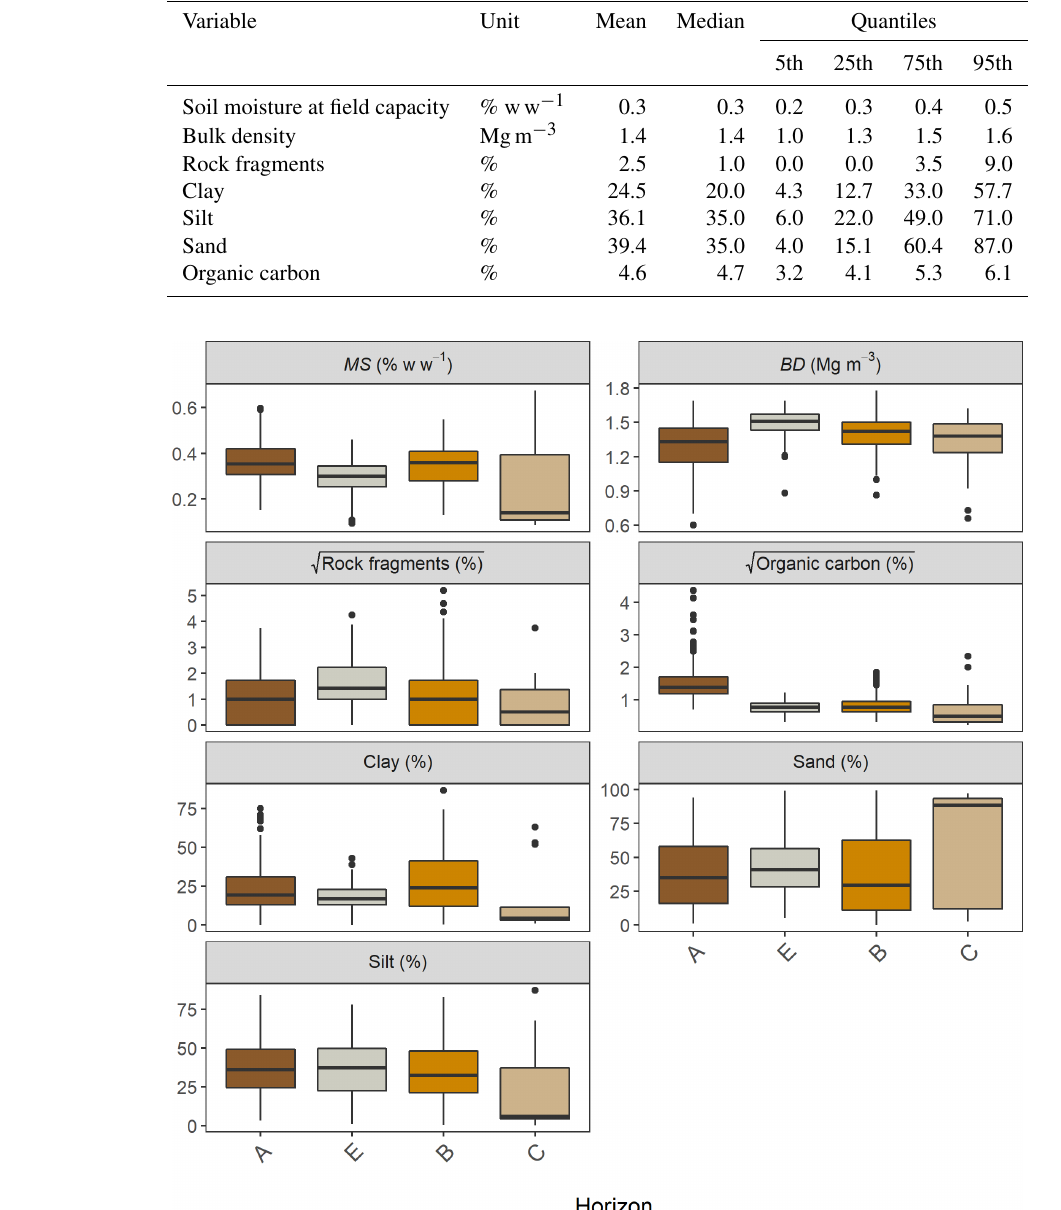
Figure 3. Boxplots of the key soil properties for each horizon of the soil profiles used in this study. Horizons which were not classified, or which occurred less than 5 times in the dataset are not shown in the figure. Organic carbon and rock fragment values underwent a square root transformation to improve the visualisation of the